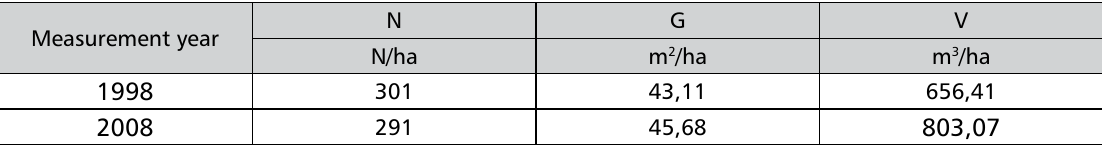
Stand structure elements of first (1998) and second (2008) measurements